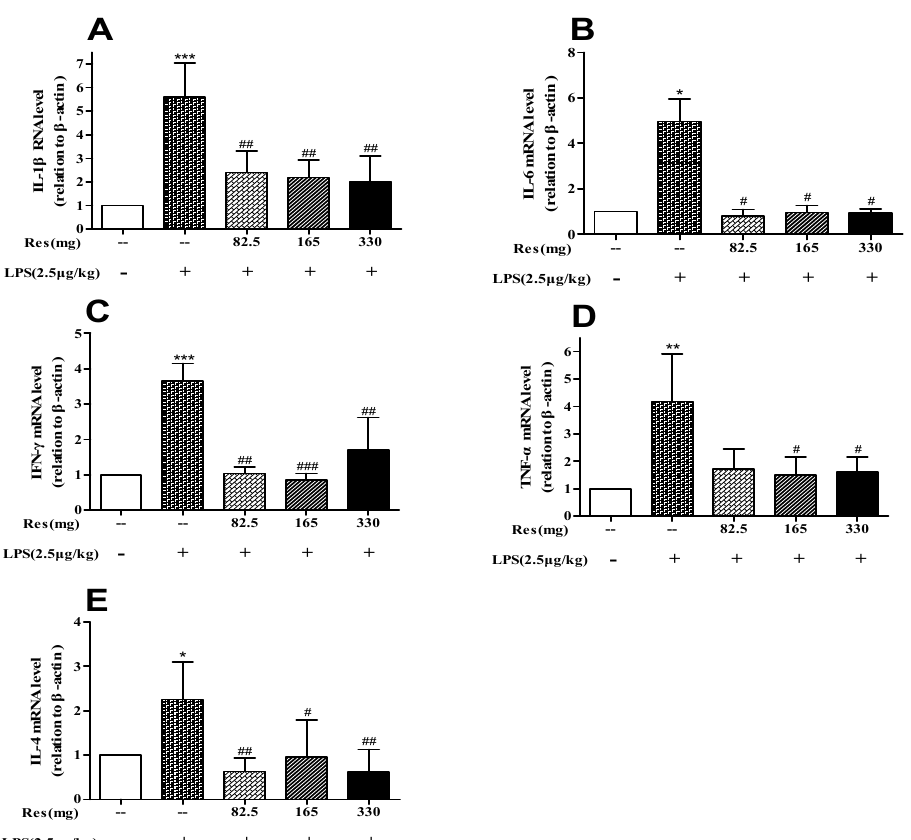
Figure 6. E ff ect of resveratrol on expression of pro-inflammatory cytokines ( A ) IL-1 β , ( B ) IL-6 , ( C ) IFN- γ , ( D ) TNF- α , and ( E ) anti-inflammatory cytokines IL-4 in LPS-challenged lambs. The values are normalized to control values and expressed as means ± SD. * p < 0.05, ** p < 0.01, and *** p < 0.001, compared with the control group; # p < 0.05, ## p < 0.01, and ### p < 0.001, compared with the LPS treatment.